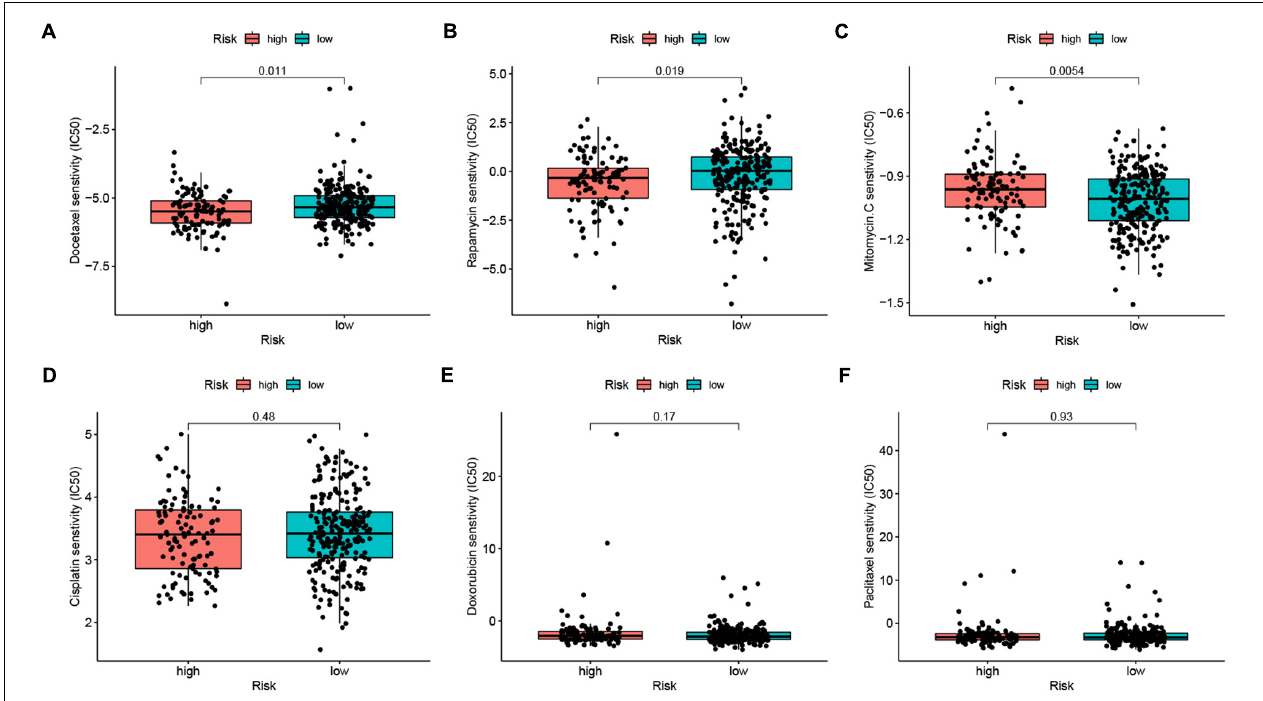
FIGURE 7 | The chemosensitivity of high- and low-risk groups. The high-risk group was related to a lower IC50 for (A) docetaxel, (B) rapamycin and high IC50 for (C) mitomycin C, whereas the IC50 of (D) cisplatin, (E) doxorubicin, and (F) paclitaxel showed no significant difference between the two